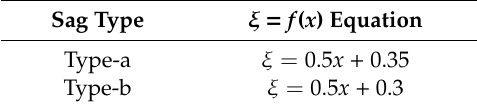
Table 3. Equations expressing ξ as a function of the sag depth x for each of the FSM states and sag types.